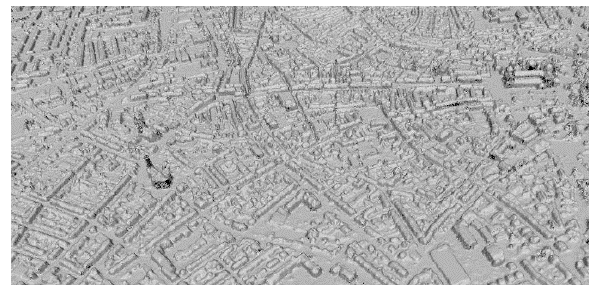
Figure 11. DSM of test area